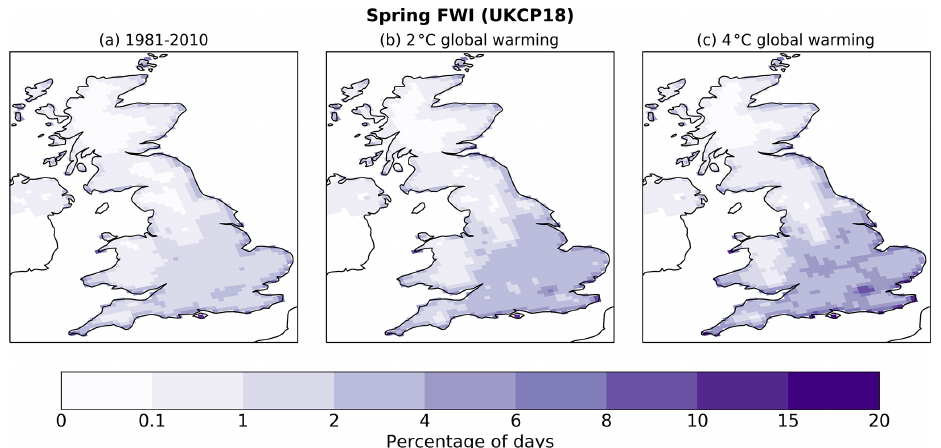
Figure 9. Percentage of spring days with high fire danger (ISI > 5) over the UK, based on the UKCP18 12km data averaged over the 12 ensemble members. (a) Historical period (1981–2010), (b) 2 ◦ C global warming and (c) 4 ◦ C global warming. The colour bar is the same as in Fig. 8a.